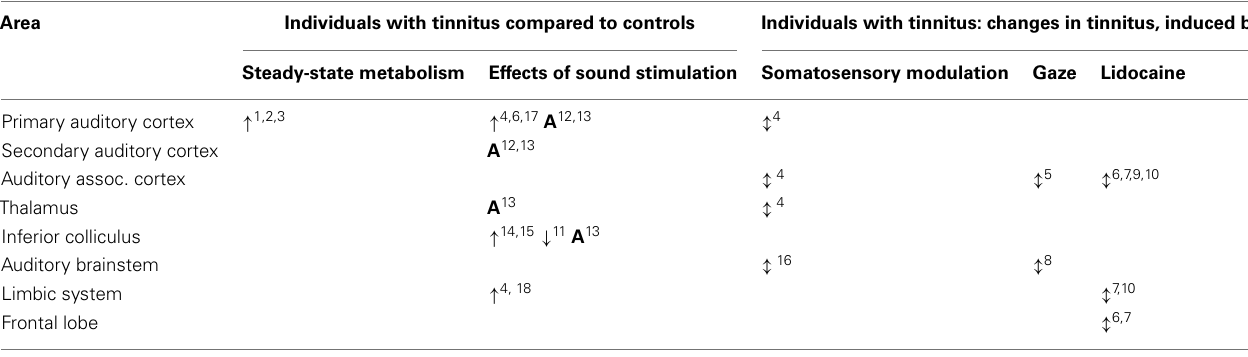
Table 3 | Functional imaging studies in individuals with tinnitus: synopsis of results. Area Individuals with tinnitus compared to